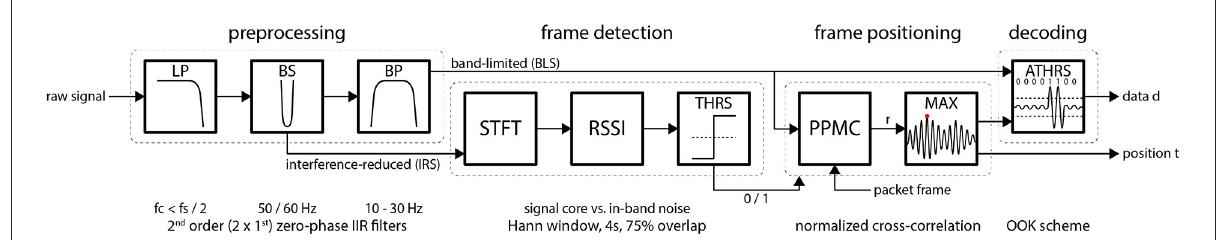
FIGURE5 The processing pipeline consists of four blocks: signal preprocessing, frame detection, frame positioning, and data decoding. First, the raw, noisy signal is filtered. While the band-limited signal (BLS) is forwarded to the frame positioning, the less preprocessed, interference-reduced signal (IRS) is provided to the frame detection block. It inspects the frequency components using a short-time Fourier transform (STFT) and assesses the signal quality applying the received signal strength indicator (RSSI). If the RSSI metric exceeds a certain threshold (THRS), the landmarks’ temporal position t is determined within the relevant interval using a Pearson product-moment correlation (PPMC). The data d is decoded according to an on-off-keying (OOK) modulation scheme applying an adaptive threshold (ATHRS)